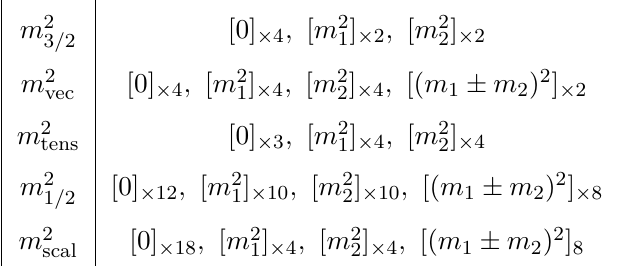
Table 17 . Masses for the Minkowski vacuum M3.